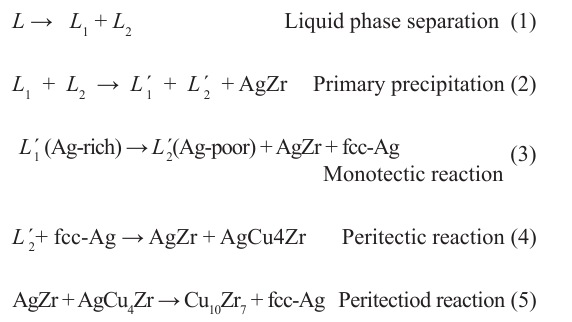
Figure 2. DSC results of the melt-spun Ag (at 30 K/min heating